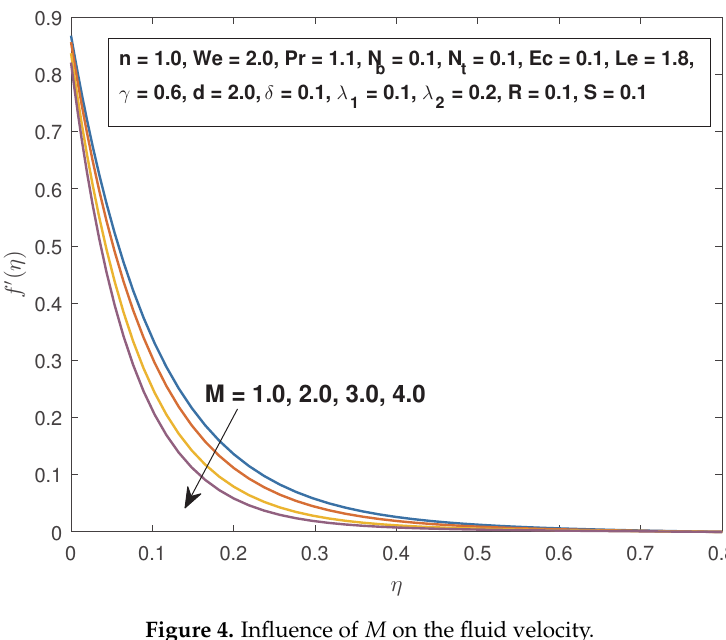
Figure 4. Influence of M on the fluid velocity.